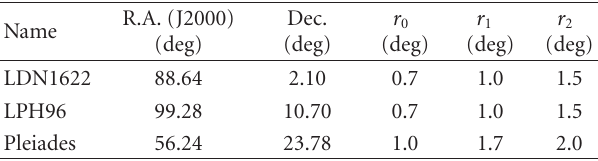
Table 2: Central positions and radii used in the aperture photome- try analysis for each